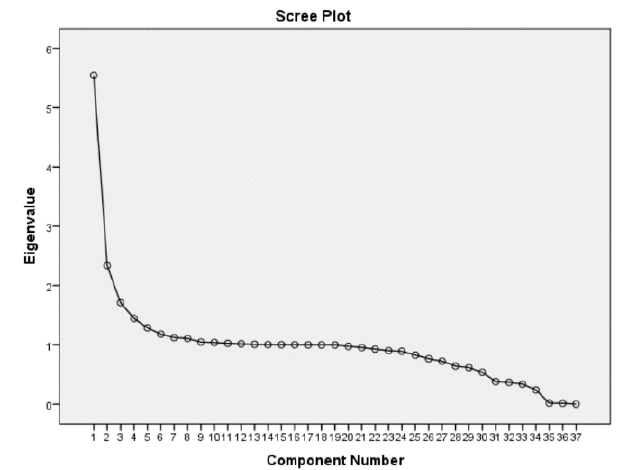
Figure 2. Scree Plot of Senegal DHS data.